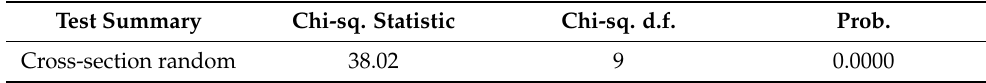
Table 4. The result of Haussmann